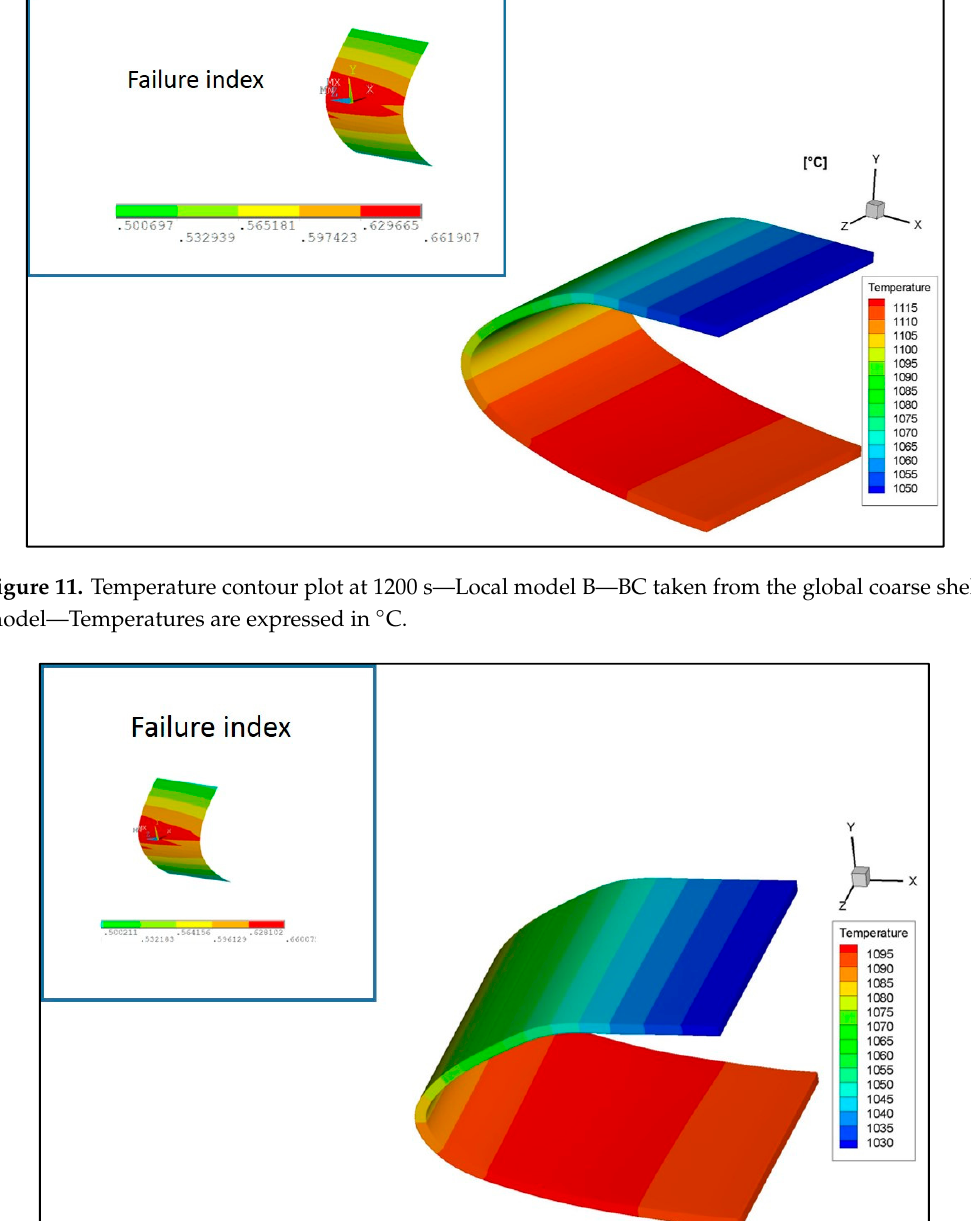
Table 6. Comparison between failure indexes from local models with BCs taken from global coarse shell and solid models.